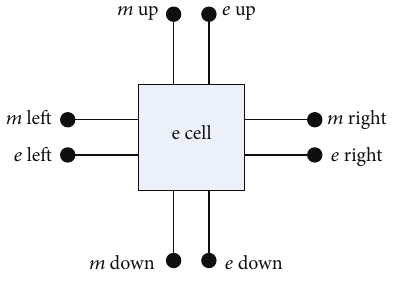
Figure 4: The elementary cell representation as a port with eight input/output